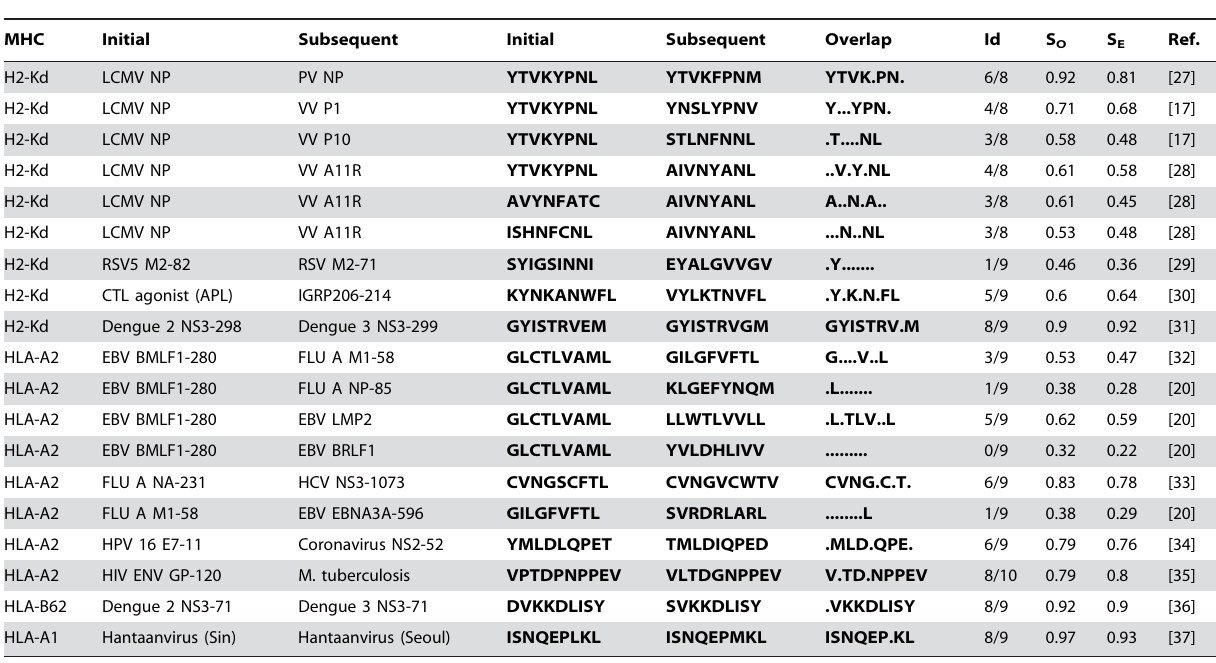
Table 1. Examples of cross-reactive epitopes reported in the